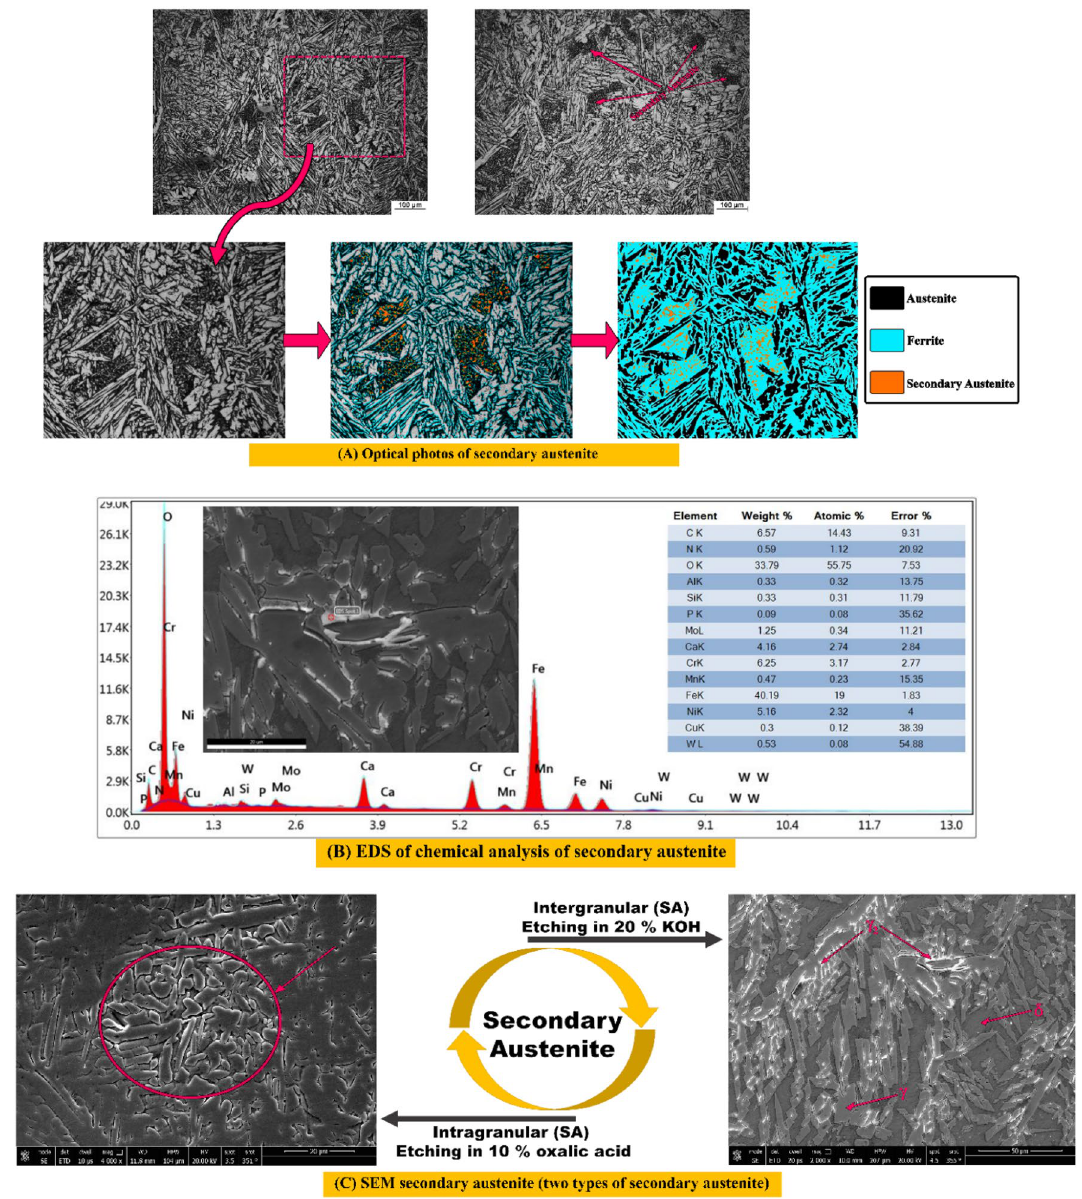
Figure 6. Optical, SEM micrographs of weld zones and EDS analysis point at secondary austenite of W sample (without PWHT